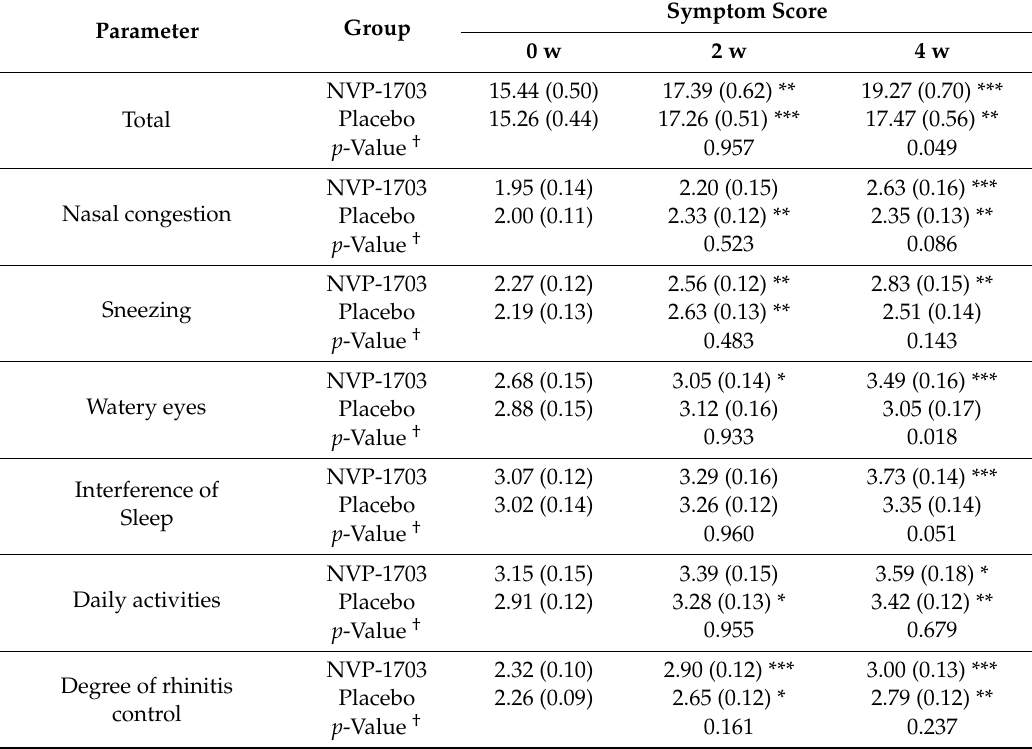
Table 3. Changes in RCAT and individual symptom scores during the study